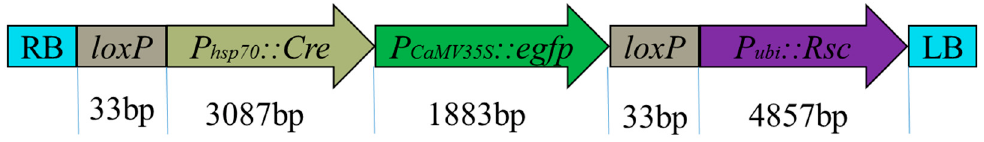
Figure 2. Transfer DNA (T-DNA) organization of the binary plasmid. LB is left border; RB is right border. loxP is the recombination-site ( lox ); P hsp70 ::Cre is the Cre gene carrying a nuclear localization signal with the heat-shock-responsive promoter Hsp70 ; P CaMV35S ::egfp is egfp gene as visual marker for selection driven by the CaMV35S (35S) promoter; P ubi ::Rsc is a reporter gene anthocyanin pigmentation ( Rsc ), controlled by the maize polyubiquitin gene ( ubi ) promoter.